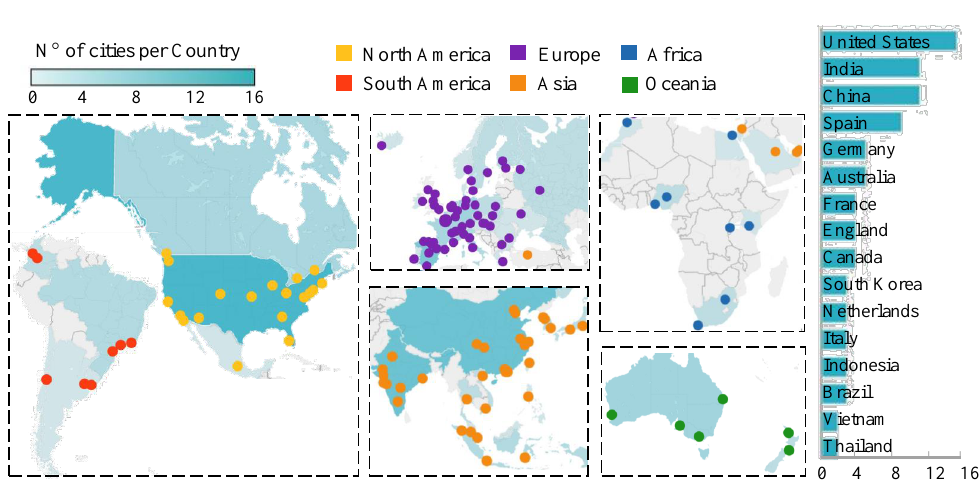
Figure 3. Map of smart cities across the world. The shade of color represents different number of smart cities per country. Cities are represented with colored points in the map, identified in six main regions: Africa, Asia, Europe, North America, Oceania, and South America. The bars on the right side show the countries with highest number of smart